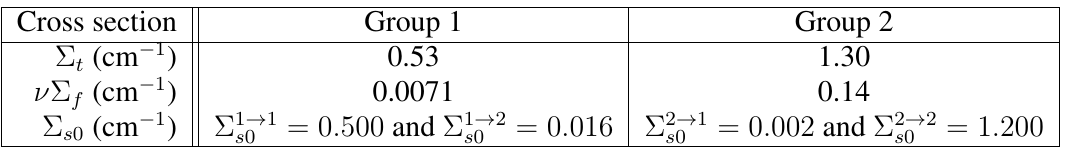
Table 1: Benchmark cross sections. Fuel and reflector share the same cross sections,